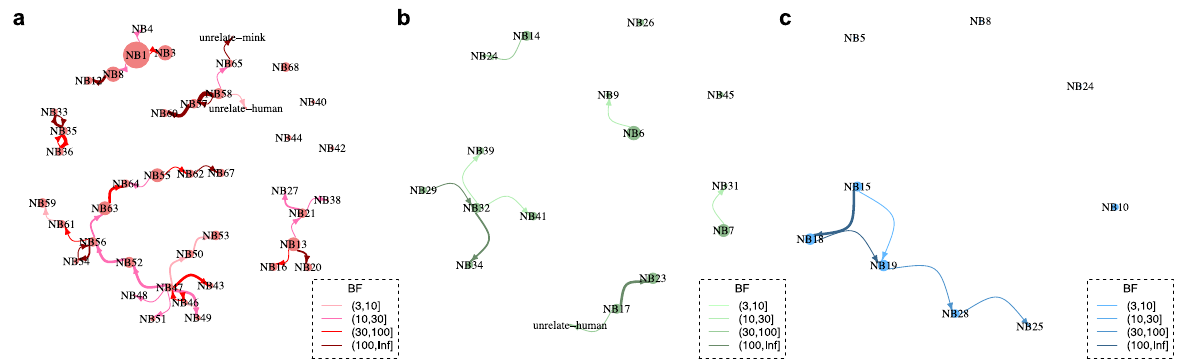
Fig. 6 Inferred transmission network between farms. Transmission network between farms inferred from phylogenies of 3 mink clusters ( a ) Cluster A ( b ) Cluster C and ( c ) Cluster D. Size of node indicates number of samples; edge weight indicates median number of transmissions between pairs of farms; arrow on edge indicates transmission direction; colour of edge from light to dark indicates Bayes Factor (BF) support from low to high (only transmissions with BF >3 are shown). The correlated farms are grouped together. Nodes with no link to the others indicated no signi fi cant transmissions with other farms although sequences belong to the cluster have been sampled. The number of transmissions and the correlated BF supports are shown in Table S3.